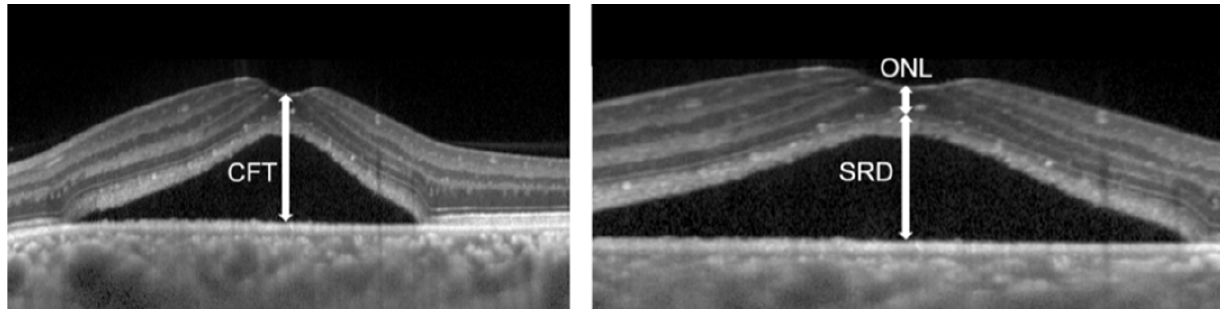
Figure 3. Optical coherence tomographic image of eyes with central serous chorioretinopathy. Horizontal optical coherence tomography images of eyes with central serous chori- oretinopathy, the serous retinal detachment (SRD) height, the central foveal thickness (CFT), and the outer nuclear layer (ONL) thickness are shown.